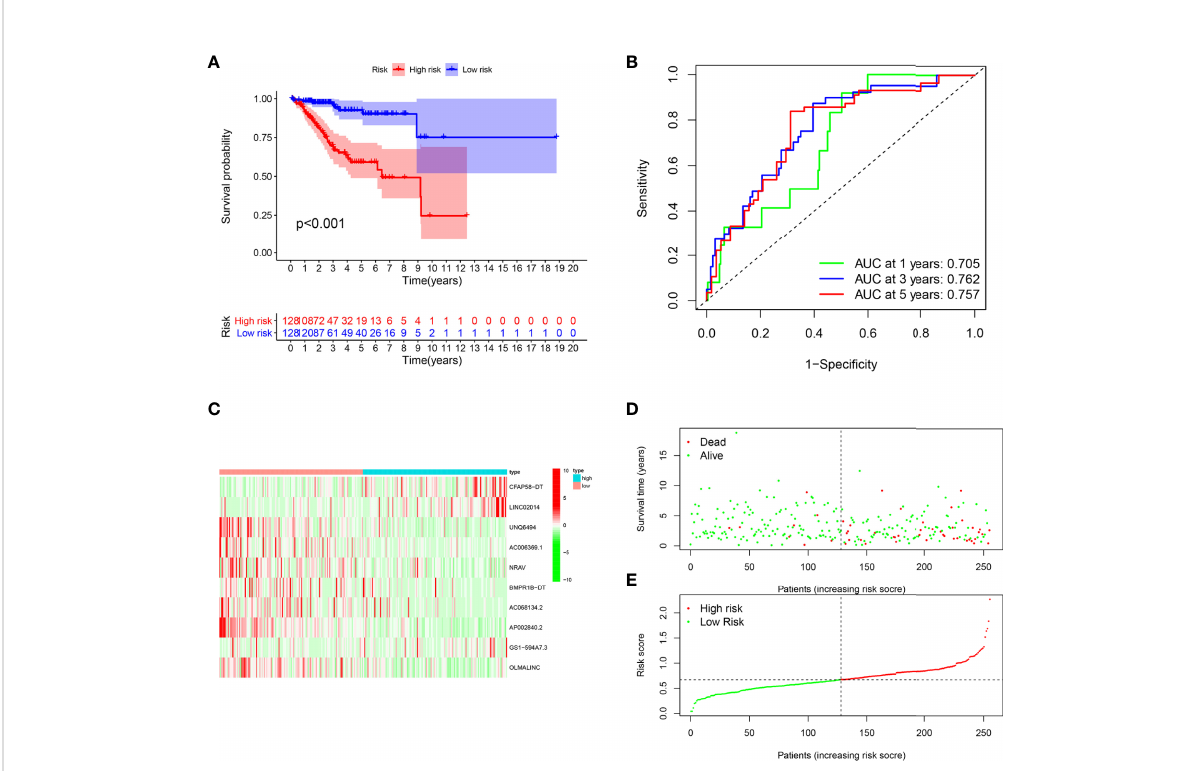
FIGURE 4 Evaluation of the prognostic value of this signature in training cohort. (A) Survival analysis showed a worse prognosis in the high-risk group ( p < 0.001). (B) The 1-, 3-, and 5-year area under the curve (AUC) values of the signature are 0.705, 0.762, and 0.757, respectively. (C)